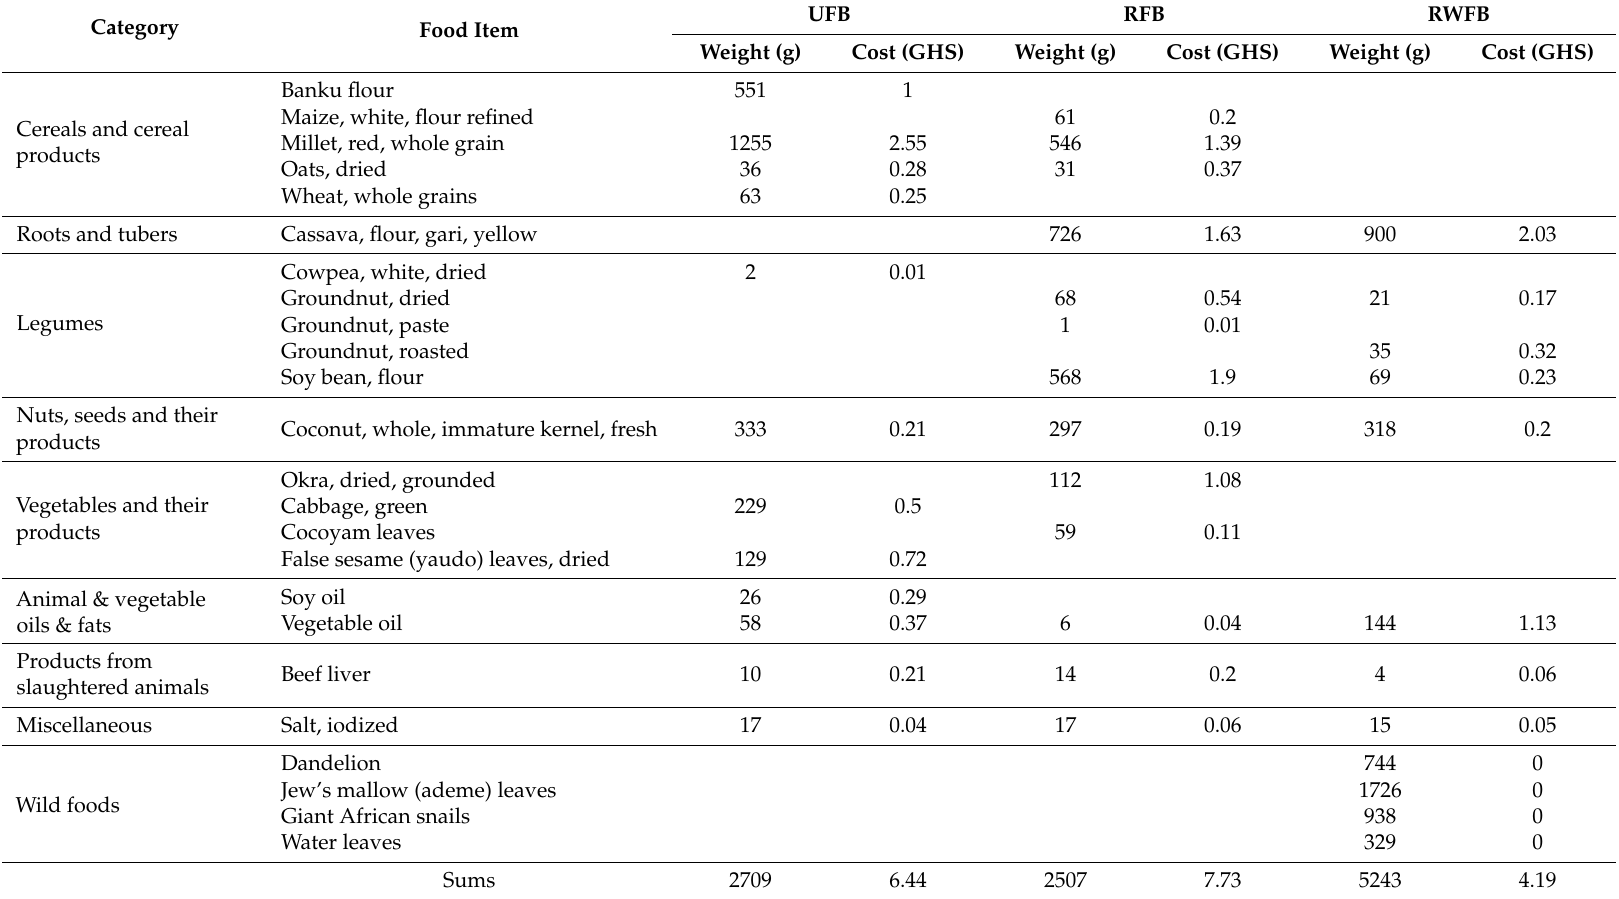
Table 2. Simplest versions of Ghanaian food baskets for the urban environment (UFB, 12 foods), for the rural environment (RFB, 13 foods) and for the rural environment including wild foods (RWFB, 12 foods). During the cost optimization by linear programming, these food baskets were not constrained to achieve any forms of diversity or similarity to current food supply patterns. GHS, Ghanaian